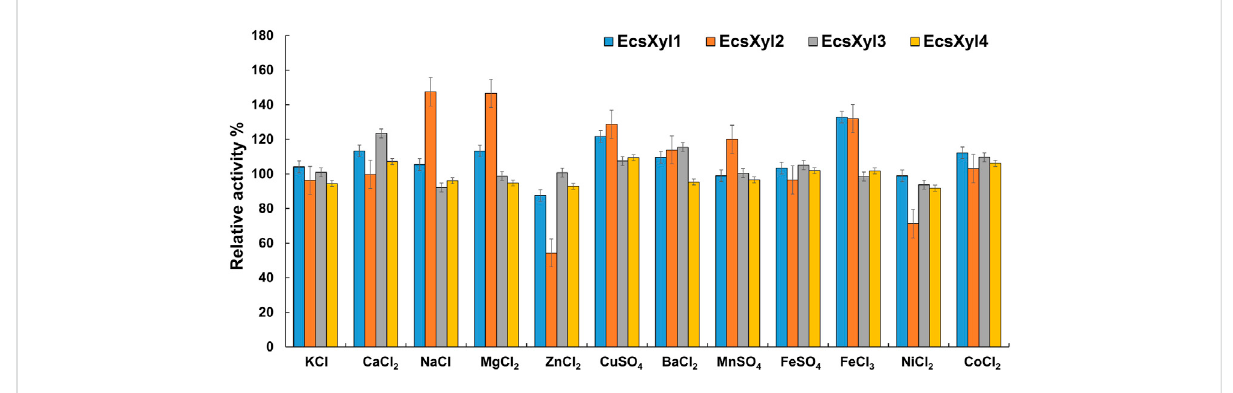
FIGURE 5 Effect of metal ions onxylanaseactivity.The activitywithoutanyaddition wasregardedas control. The barsshow thehybridxylanase activity of EcsXyl1 – EcsXyl4, respectively, in the presence of metal ions (1 mm).